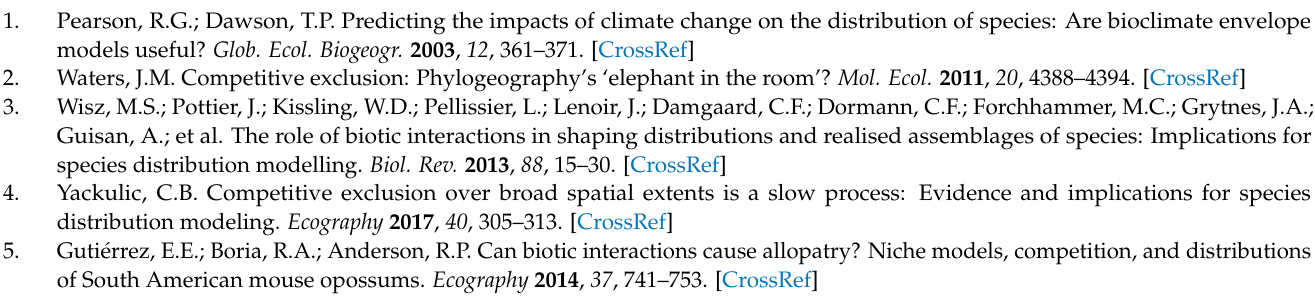
Figure S9: Phylogenetic trees of ND II sequences and geographic locations: Hyla japonica , Figure S10: Distribution maps of Siberian weasel (a) and Brown bear (b), Figure S11: Distribution maps for Oryzias sinensis , based on Takehana et al. (2004), Table S1: Correspondence of the sequence name between ND2 and cytochrome b, Table S2: Location of the 21 areas throughout Korea and Japan, Table S3: Genotypes and frequency at the PEPA locus and their clade type at the three river